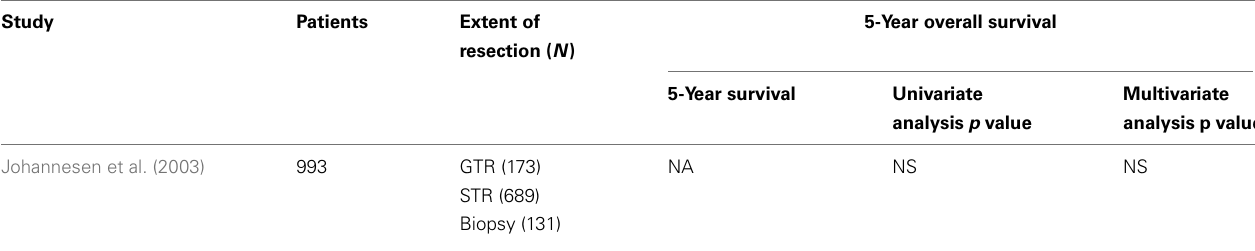
Table 6 | Negative, non-volumetric studies of EOR in low-grade